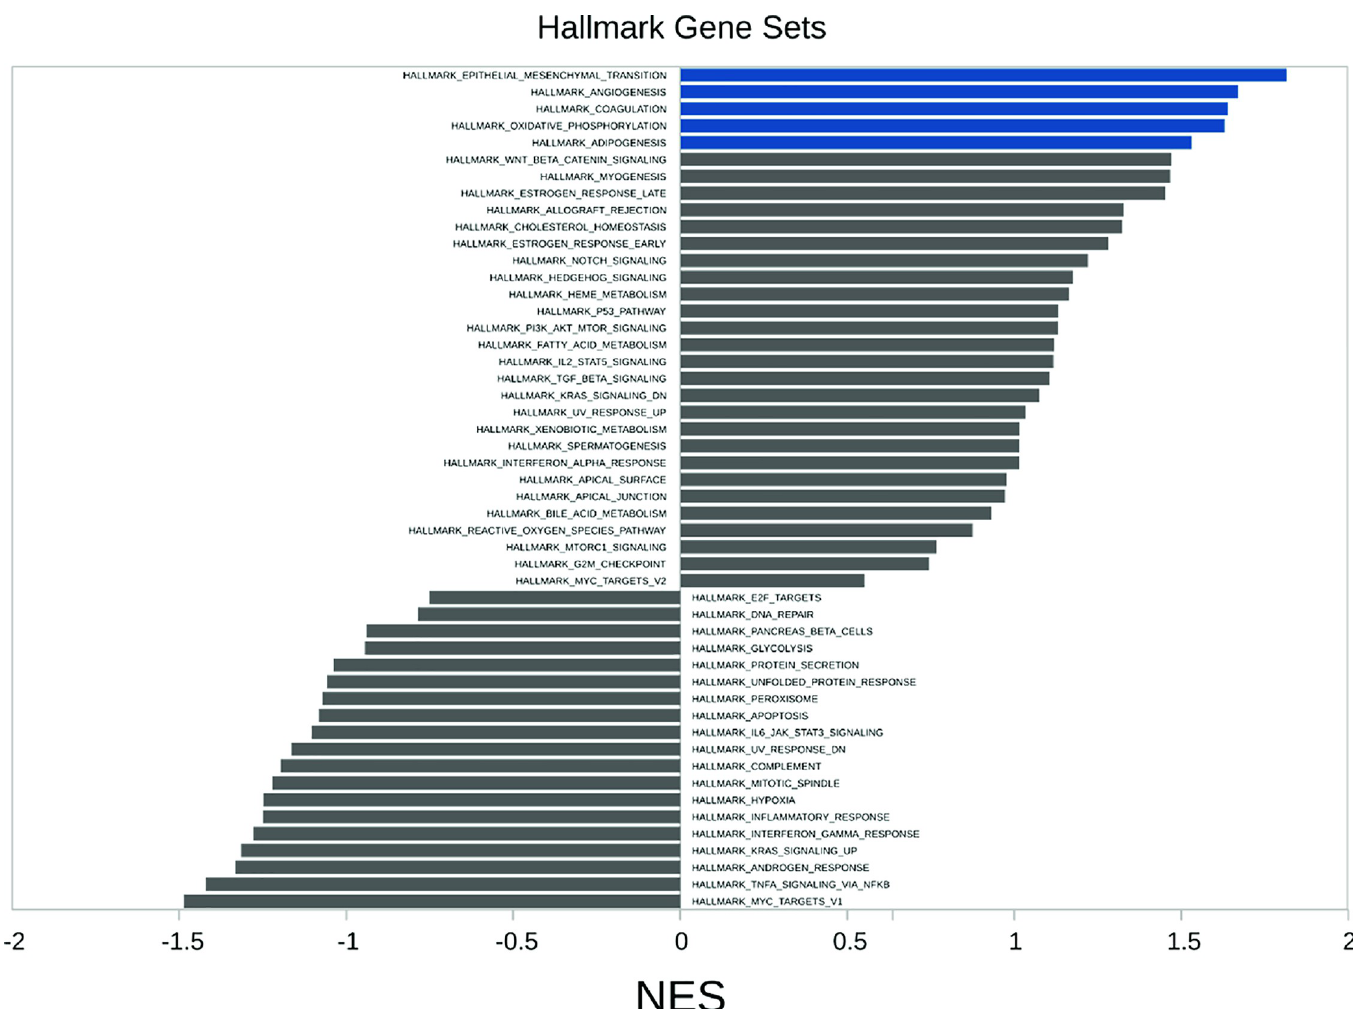
Fig 3. Gene set enrichment analysis (GSEA) using Hallmark gene sets. GSEA comparing T1 versus T2 LCL gene expression was performed using the different Hallmark gene set collection from MSigDB; positive enrichment scores correspond to gene sets enriched in T2 LCL upregulated genes and negative enrichement scores correspond to gene sets enriched in genes upregulated in T1 LCLs. Blue bars are significant with FDR < 0.05.